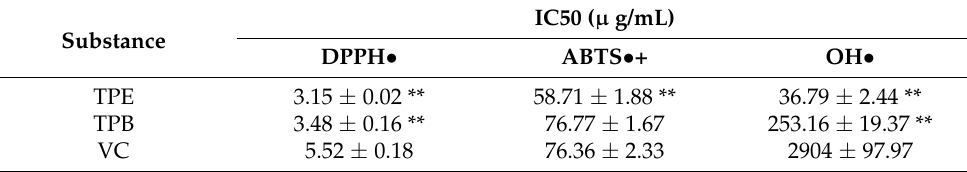
Table 1. IC50 values of TPE and TPB in free radical scavenging experiments.